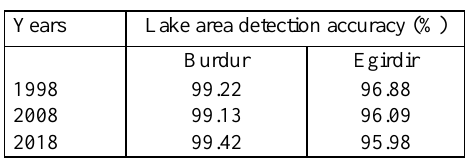
Table 1 . The overall accuracy values of extracted lake areas for the years 1998, 2008 and 2018.